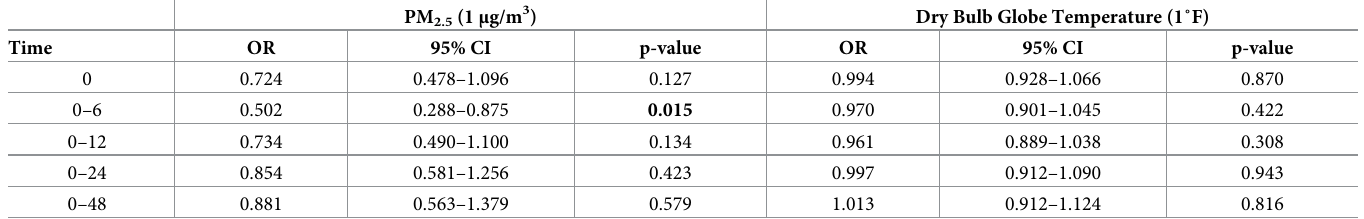
Table 6. Adjusted odds ratios of rescue bronchodilator usage for PM 2.5 and DBGT in the same model for participants in the